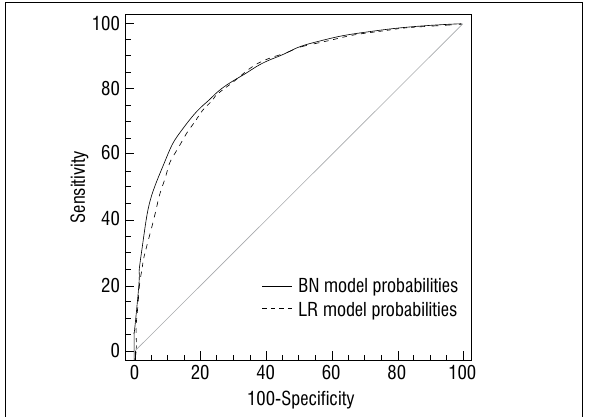
Figure 6: Receiver operating characteristic curves comparing the prediction accuracy of the Bayesian network (BN) model with the logistic regression (LR) predictive